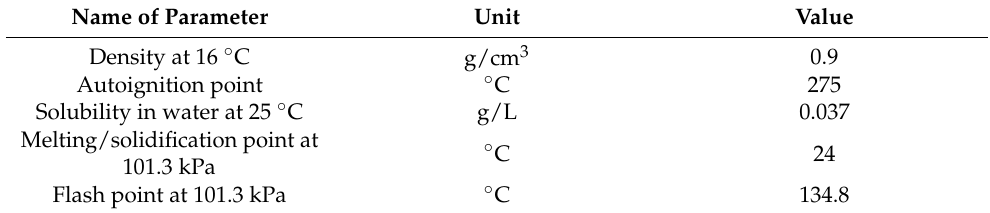
Table 3. Basic properties of dodecanol